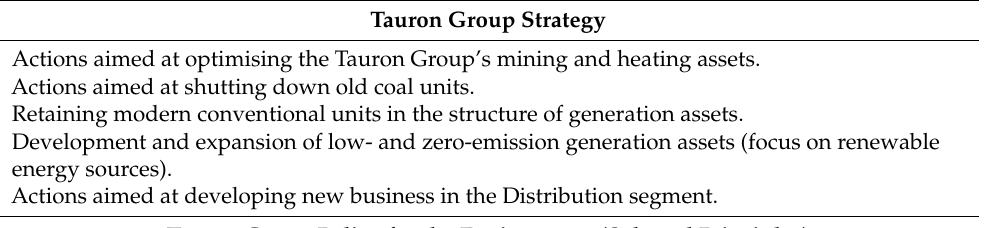
Table 2. Tauron Capital Group strategy and policies for the environment and climate. Tauron Group